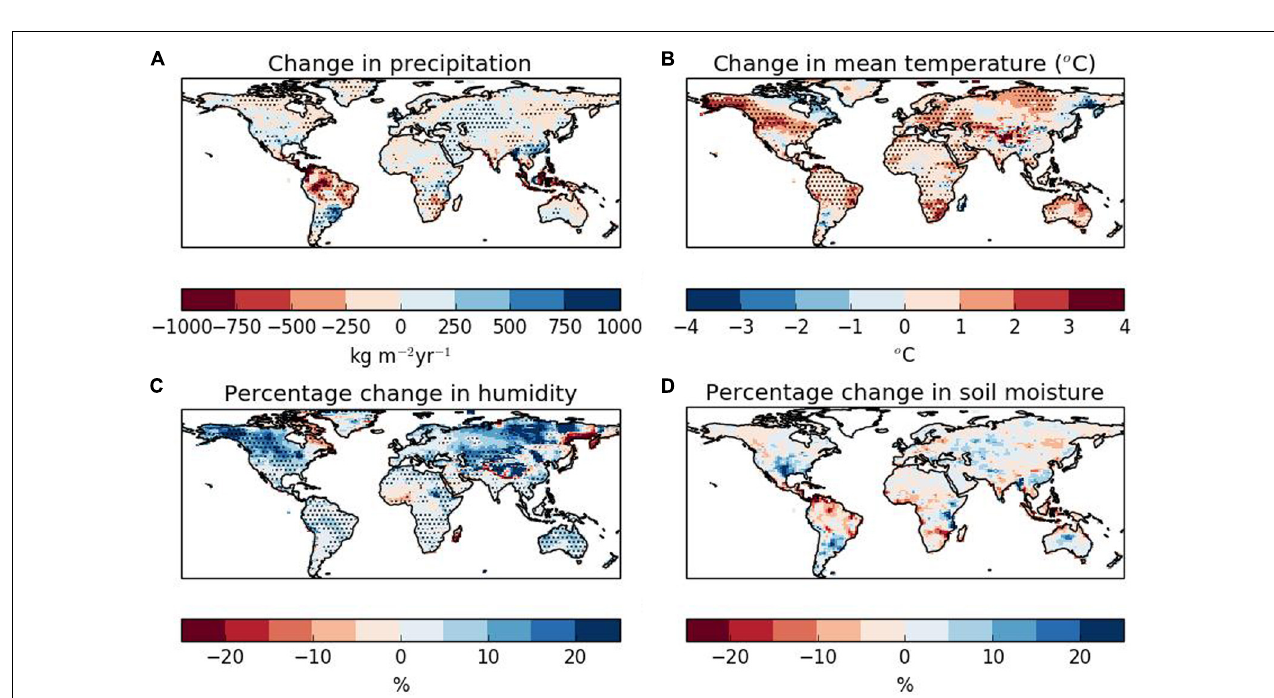
FIGURE 6 | Drivers of burned area with El Niño, July 2015–June 2016. From CRU-NCEP driving data: Percentage change in annual precipitation (A) , change in mean temperature (B) , and percentage change in specific humidity (C) . Stippling indicates where the change is large compared to natural variability across 2005–2014 (greater than two standard deviations). Modeled by JULES: percentage change in soil moisture (D) .